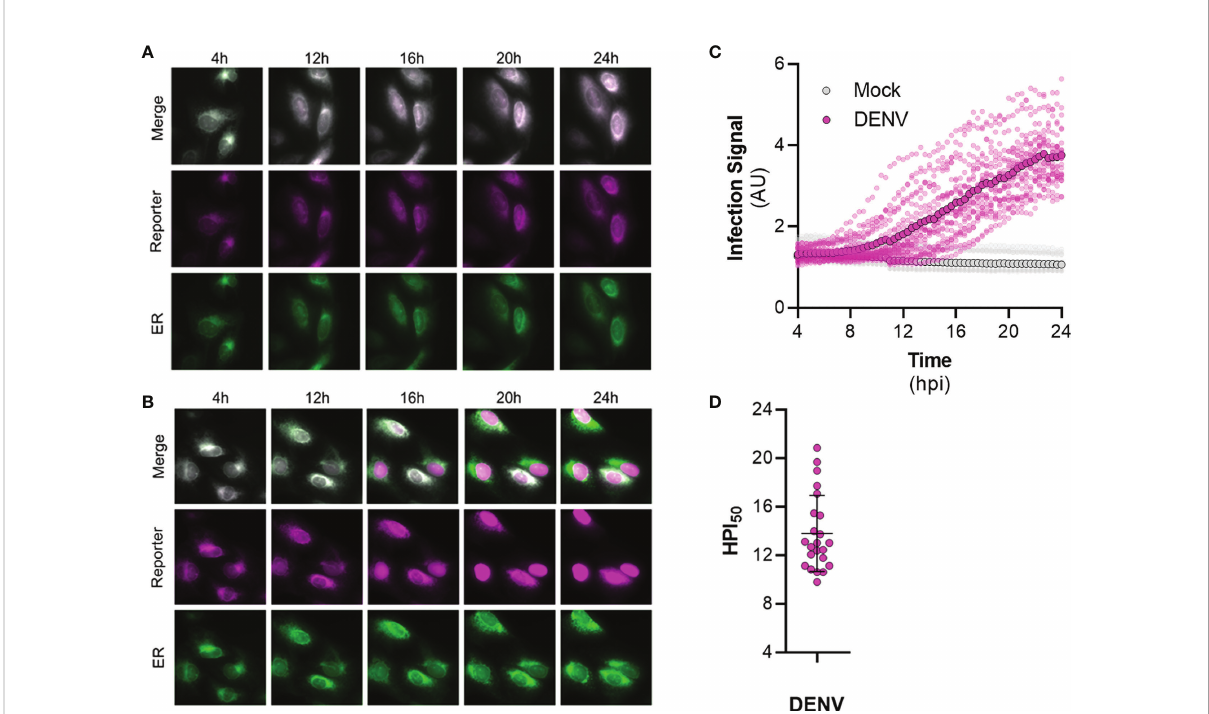
FIGURE 7 Time-lapse imaging of DENV infected cells expressing FlavER. (A, B) Representative time-points of an image series from live-cell imaging of the reporter signal (magenta), the ER marker (green), and merged panels from mock (A) or DENV infected (B) U2OS cells expressing FlavER. Scale bars represent 20 m m. (C) Quanti fi cation of infection intensity, de fi ned as the ratio of reporter to ER fl uorescence intensity signals within the nucleus from individual mock (gray, n=12) or DENV infected (magenta, n=23) U2OS cells expressing FlavER. Images were taken every 20 minutes, and infection intensity was calculated for every frame throughout a 20-hour time-lapse imaging experiment. Individual data points represent the average reporter intensity at the indicated timepoint. (D) Determination of the timepoint at which the 50% maximum reporter signal was observed in the nucleus (HPI50) as determined by nonlinear regression analysis for individual DENV-infected cells